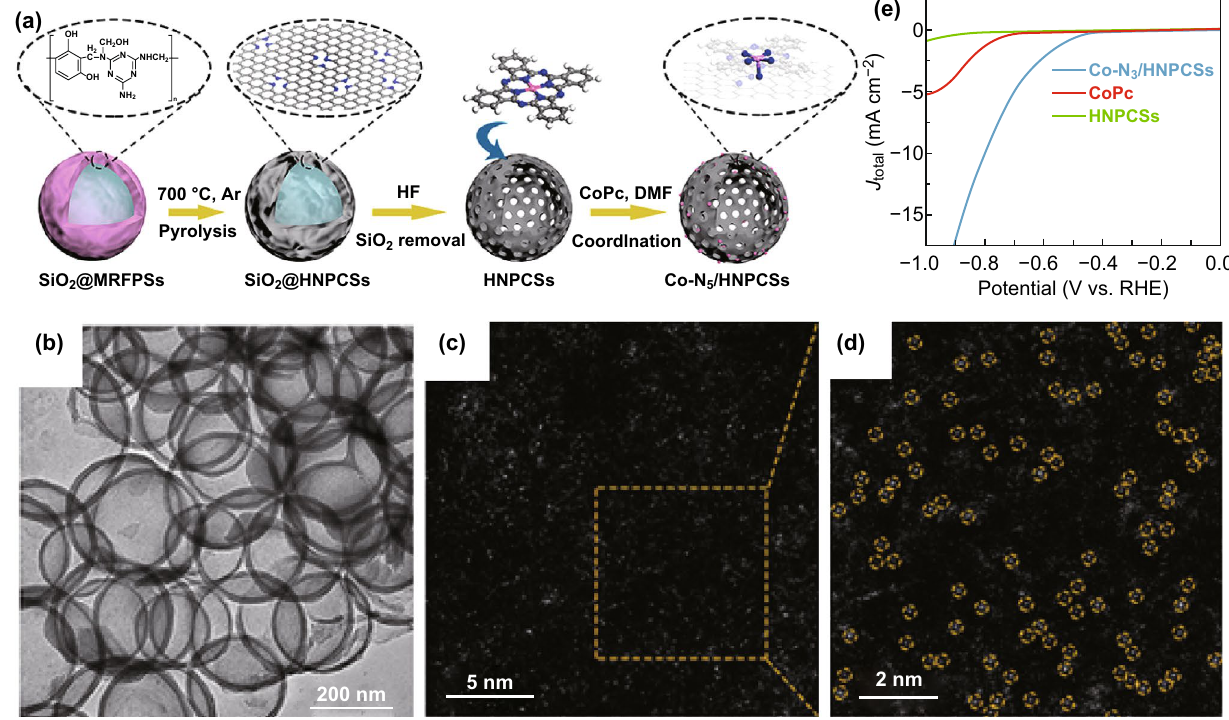
Fig. 5 a Schematic illustration, b TEM, c HAADF-STEM image of Co-N 5 /HNPCSs. d AC-HAADF-STEM and magnified images of Co-N 5 / HNPCSs. e LSV curves. a – e Reproduced from Ref. [149] with permission. Copyright 2018 American Chemical